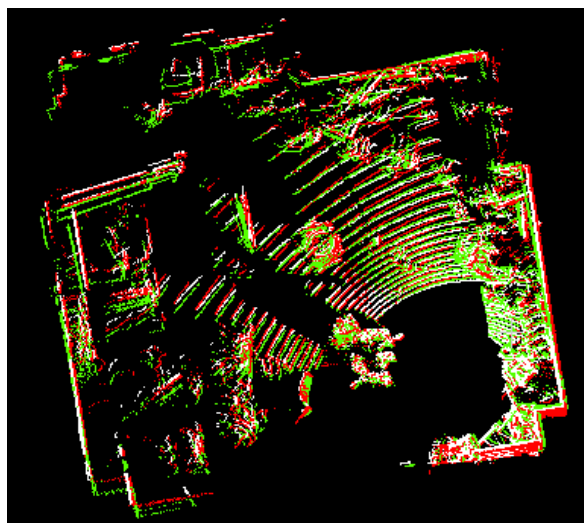
Figure 6. Output of the proposed algorithm (red is 1 st , green is 2 nd scan and white is registered point clouds) In the second approach, the registered point cloud with the proposed algorithm is compared with result of ICP algorithm.